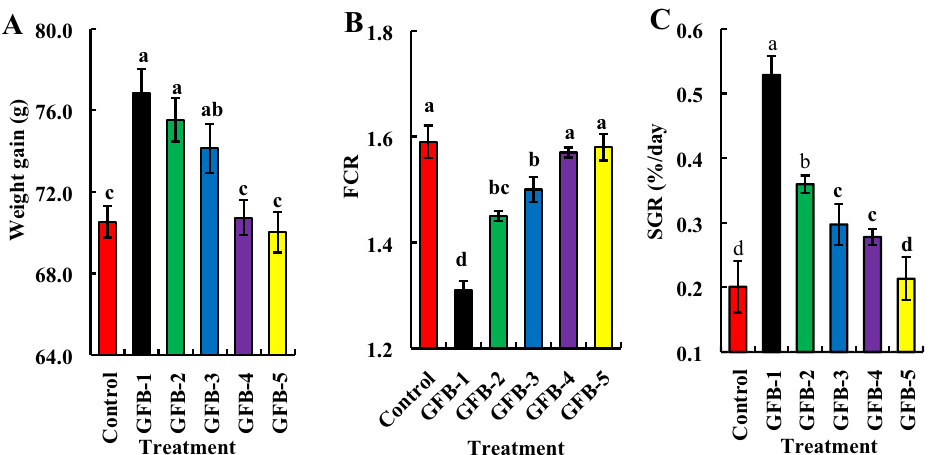
Figure 3. Assessment of individual effects of five probiotic bacterial strains viz. GFB-1, GFB-2, GFB-3, GFB-4 and GFB-5 isolated from the gut of B. gonionotus on growth parameters (A, B, and C) of the host fishes. One way ANOVA was performed for analyzing the data of three replicated experiment and data in column varies significantly in LSD at P < 0.05 (Statistix 10). Different letter bars indicate significant variations in ( A ) Weight gain data collected were repeated statistically analysed using ANOVA to test significance results ( P < 0.05) between means, (B) food conversion ratio (FCR) and (C) specific growth rate (SGR) of fish in different groups by the isolates at P < 0.05 (Statistix 10). Error bar = ± SD; n = 48. Standard error (± SE) was calculate to identify the range of means. These statistical analyses were performed with the aid of the computer software SPSS 26.0 version. R 2 values are as follows: Control (0.747); GFB-1 (0.865); GFB-2 (0.838); GFB-3 (0.846); GFB-4 (0.748); GFB-5 (0.687).